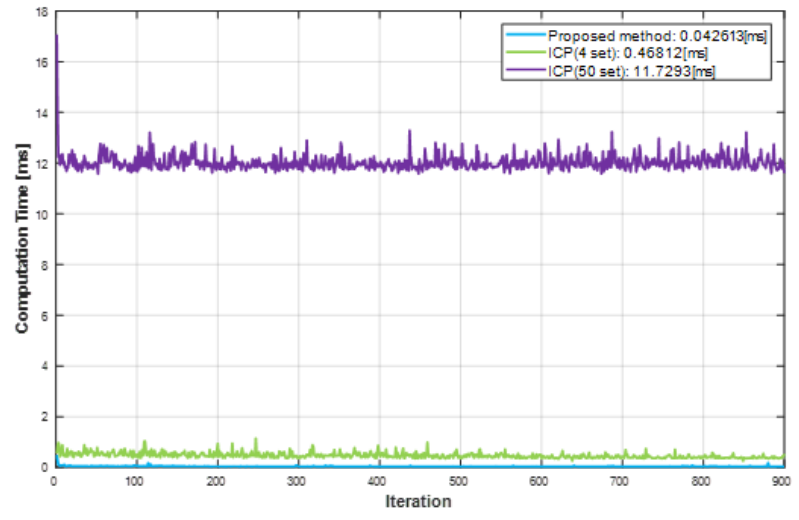
Figure 11. Result of computation time analysis.